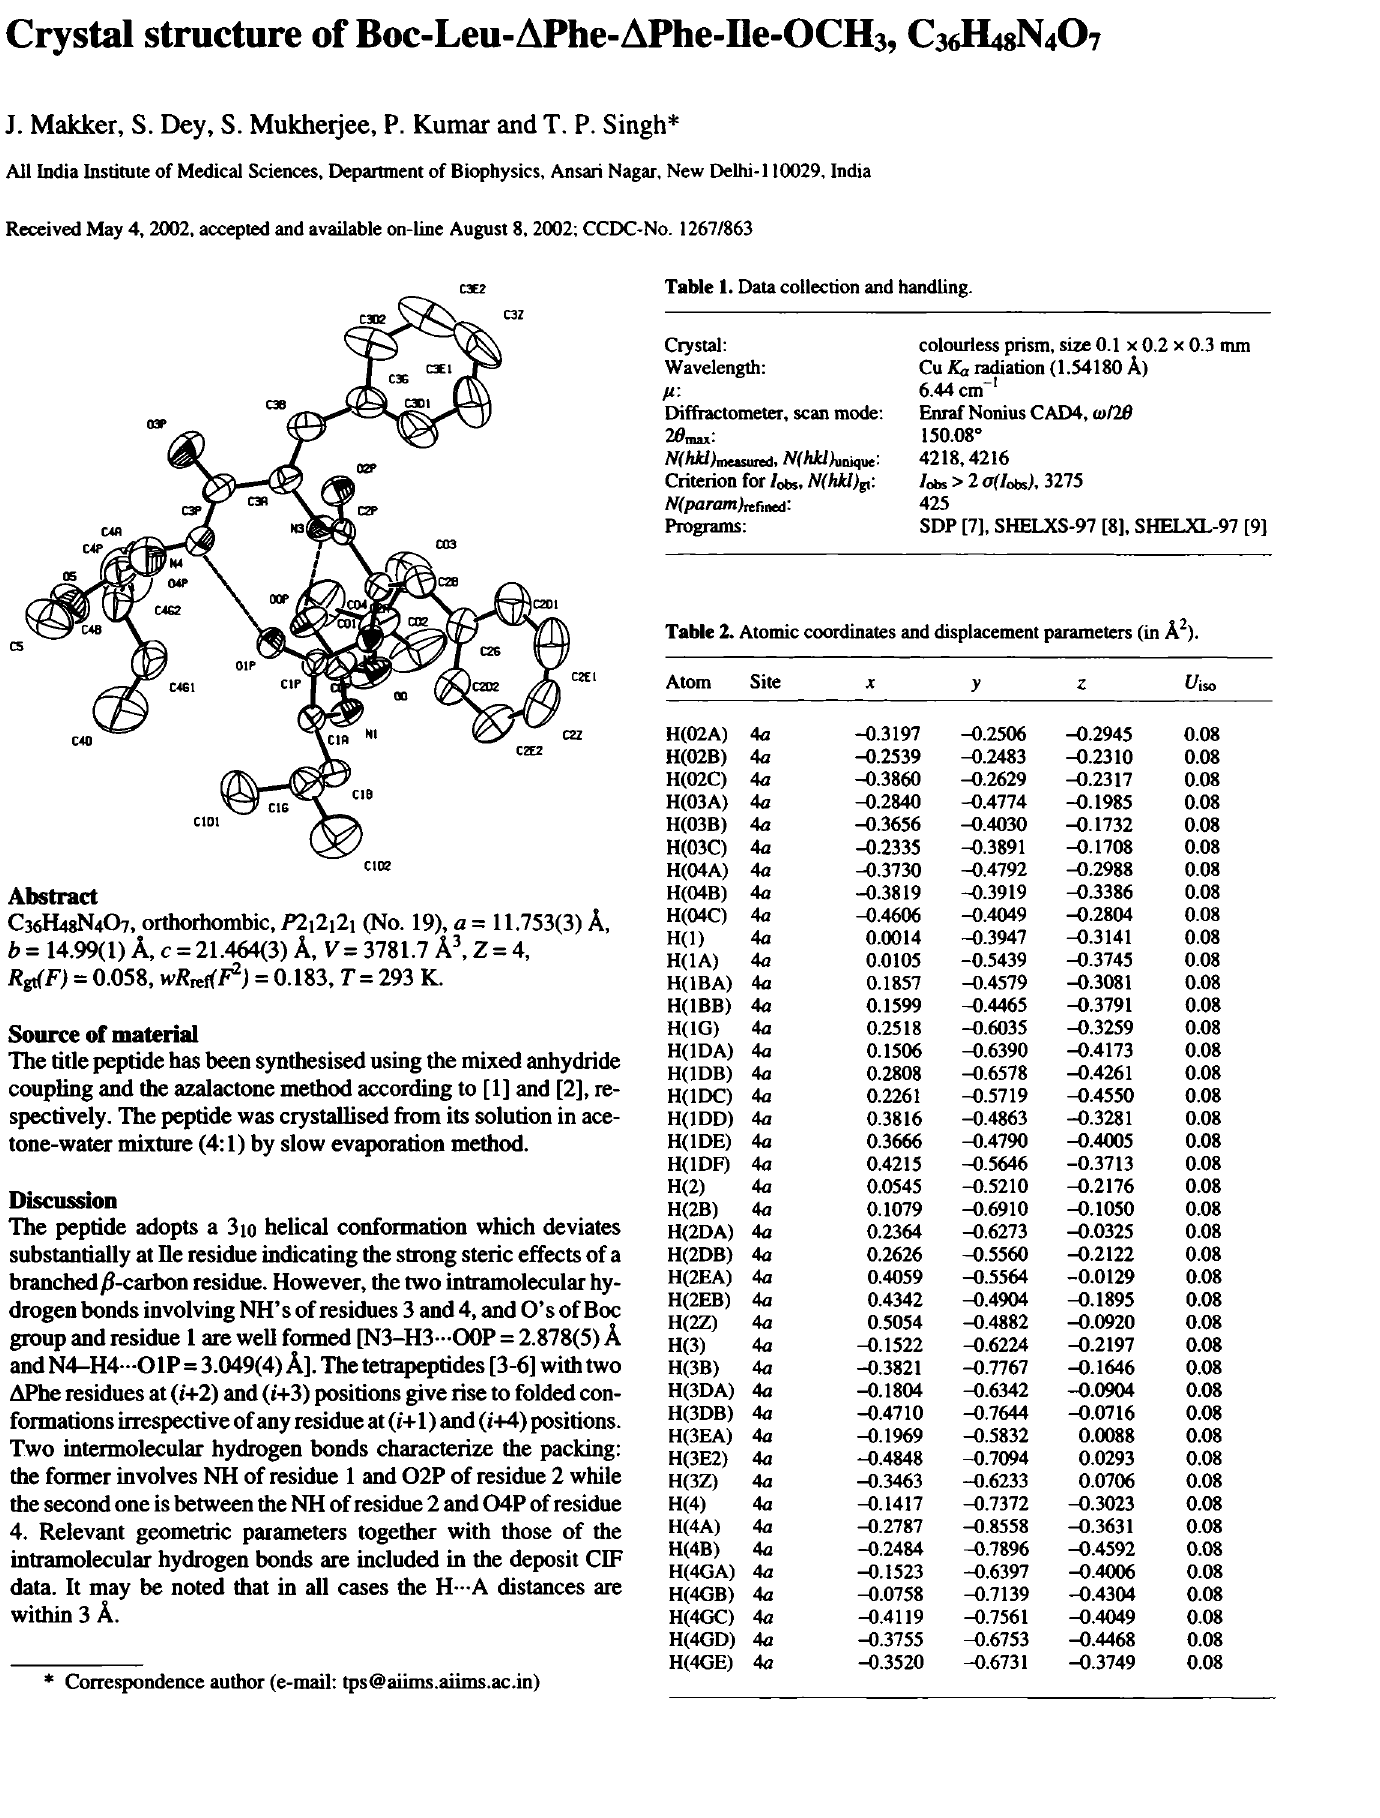
Table 1. Data collection and handling.